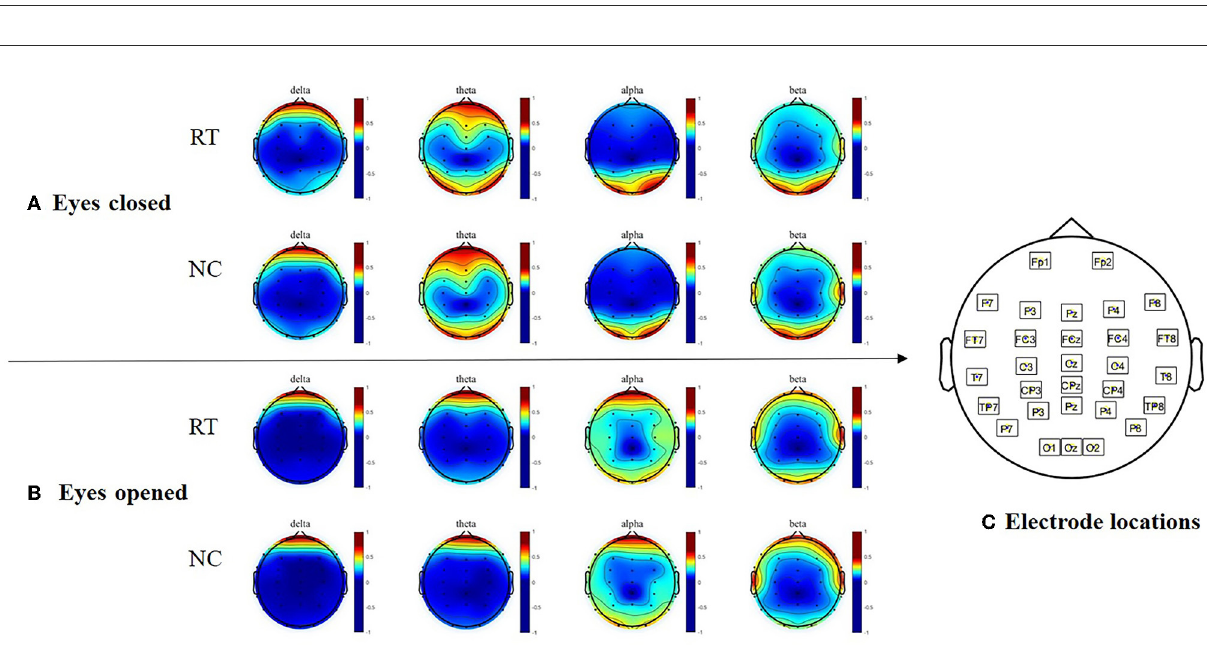
effect of the item type was also significant, F (1,73) = 82.300, p < 0.001, η p² = 0.530, and the arousal rate for the rumination